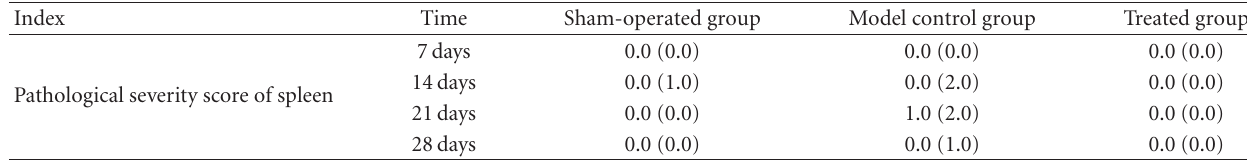
Table 6: Comparision of pathological severity score of spleen in OJ group ( M ( Q R )).